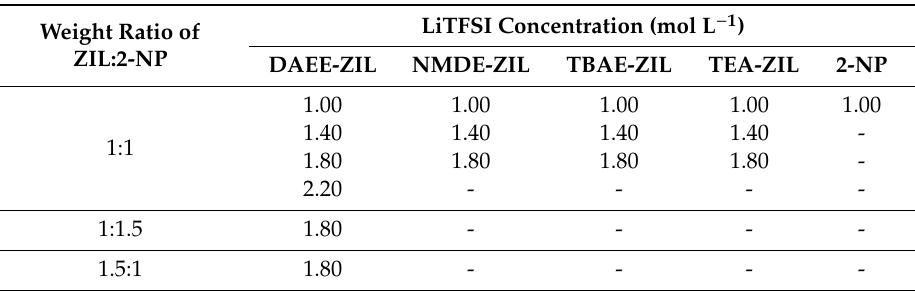
Table 8. Electrolyte formulations investigated in this study.